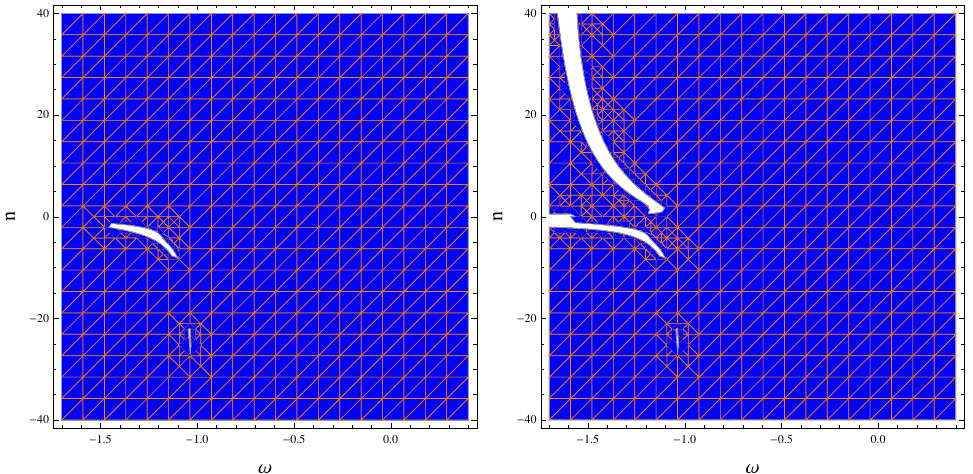
Figure 2. Stable regions of the ESU for K = − 1, λ = 2 (blue) and λ = 15 (orange), corresponding to η = 1 ( left ) and η = − 1 ( right